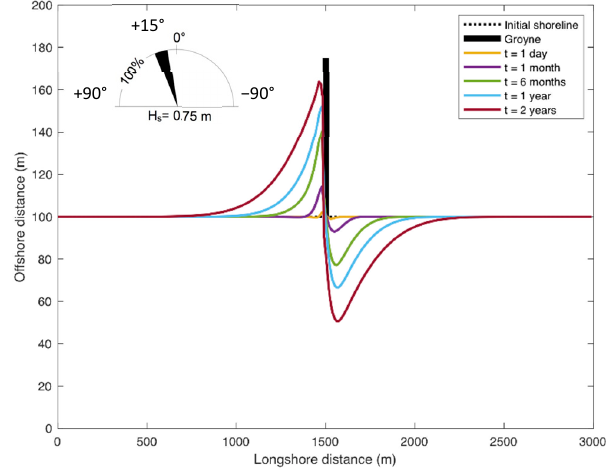
Figure 7. Calculated shoreline evolution for t = 1 day, 1 month, 6 months, 1 year, 2 years.